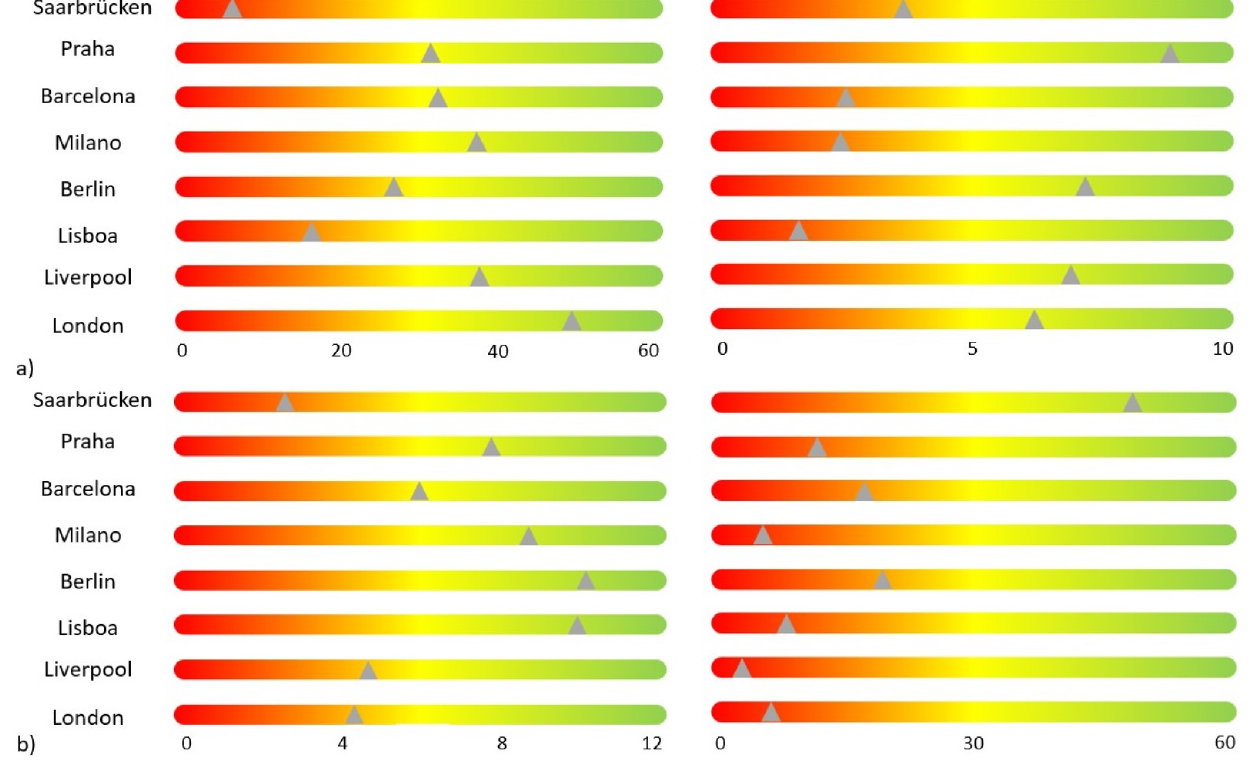
Figure 2. Left side: spectrum charts showing relative values (%) of observations in green areas ( a ) and in forests ( b ); relative values were calculated as a percentage ratio between the total number of observations in the two types of green spaces and the total number of observations within the city. Right side: spectrum charts showing the relative values (%) of green areas ( a ) and in forests ( b ) for the respective cities; relative values were calculated as a percentage ratio between the areas of the two types of green spaces and the total area of the city. The charts refer to the first eight cities with the highest total observations.